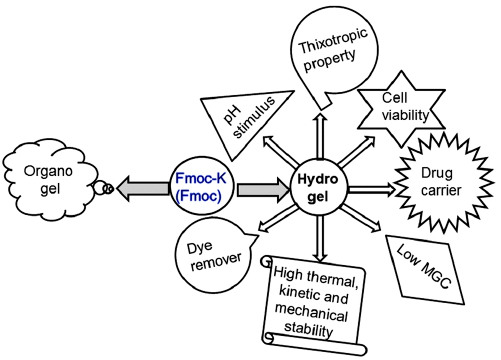
Figure 3. This cartoon diagram summarizes all the possible applications of the hydrogels prepared with the Fmoc-K(Fmoc) gelator. Image adapted with permission from reference [42]. Copyright 2015 Royal Society of Chemistry.